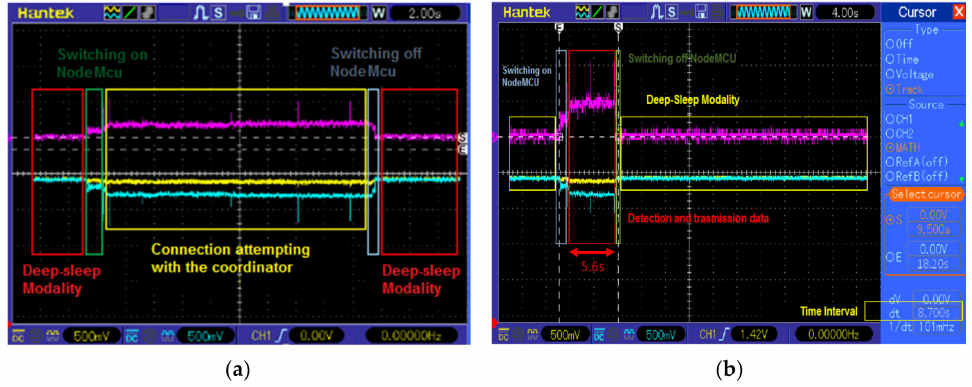
Figure 13. ( a ) Oscilloscope traces acquired during unsuccessful connection attempt of the sensor node with coordinator node; after 20 s, the node returns in deep sleep mode to reduce the power consumption; ( b ) oscilloscope traces acquired during a successful connection of the sensor node with coordinator node; only 5.6 s were required to complete the data detection and transmission